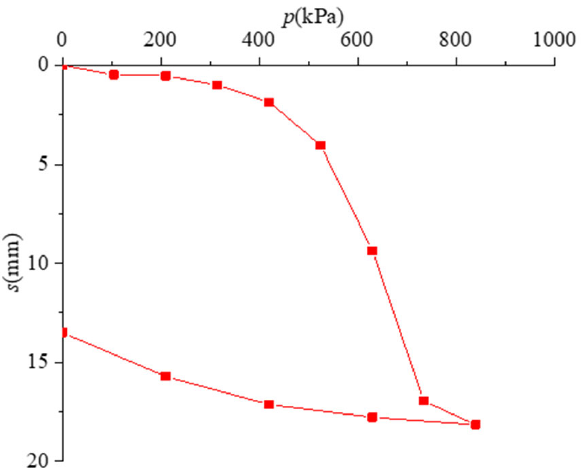
Figure 5. p – s curve by shallow plate loading test in 9#